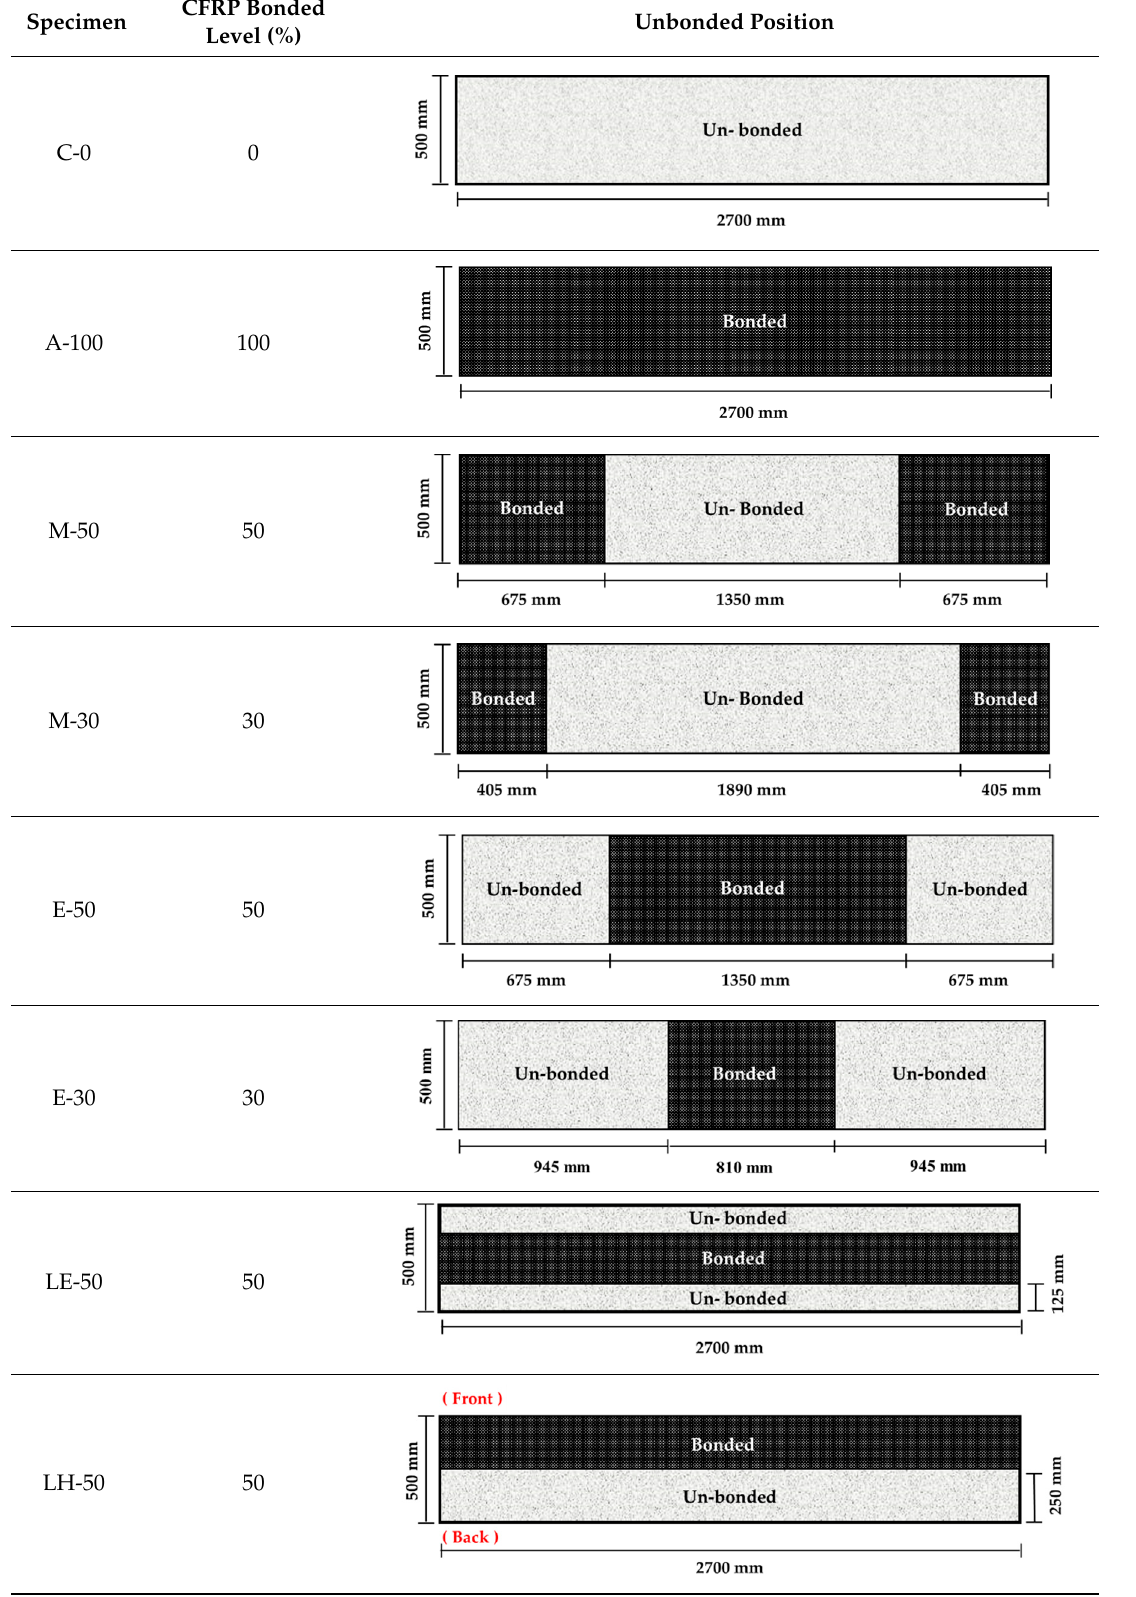
Table 1. Experimental variable details.